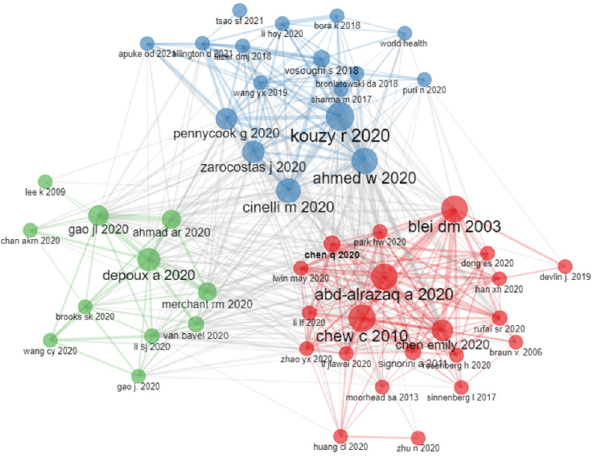
Figure 6. Co-citation network (this network was generated by Biblioshiny).